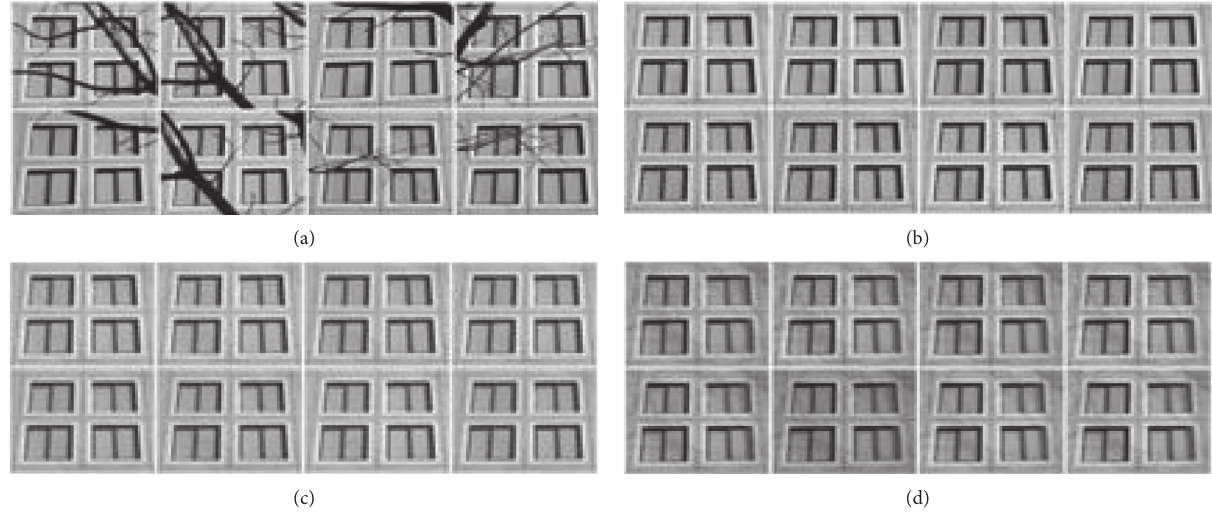
Figure 5: Some recovered complicated window images. (a) Original, (b) NQLSD, (c) RASL, and (d) proposed